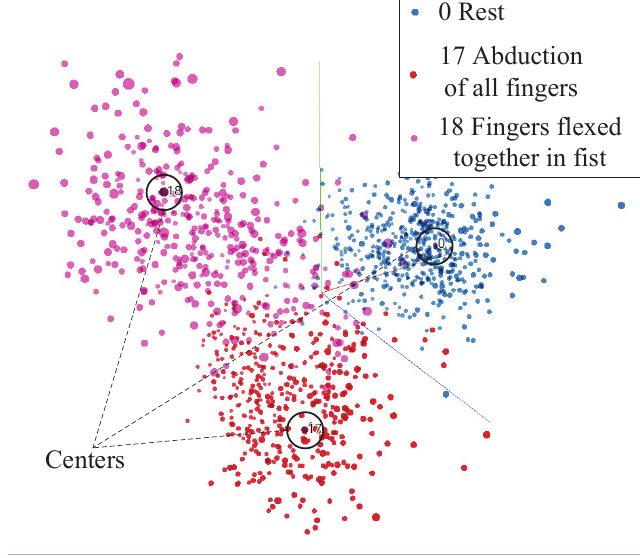
Figure 7. Distributions of hand rest, hand open, and hand close in the feature space. Total variance described: